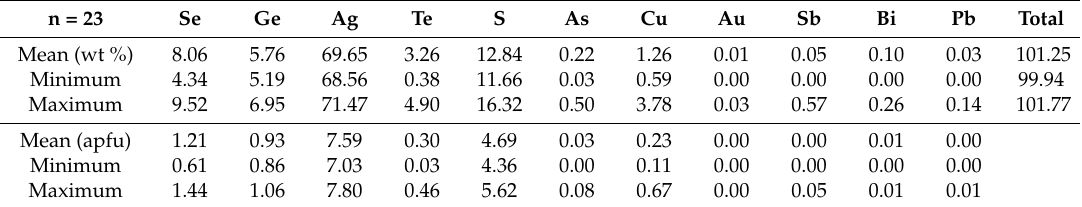
Table 4. Electron microprobe composition of argyrodite from Mt Carlton.